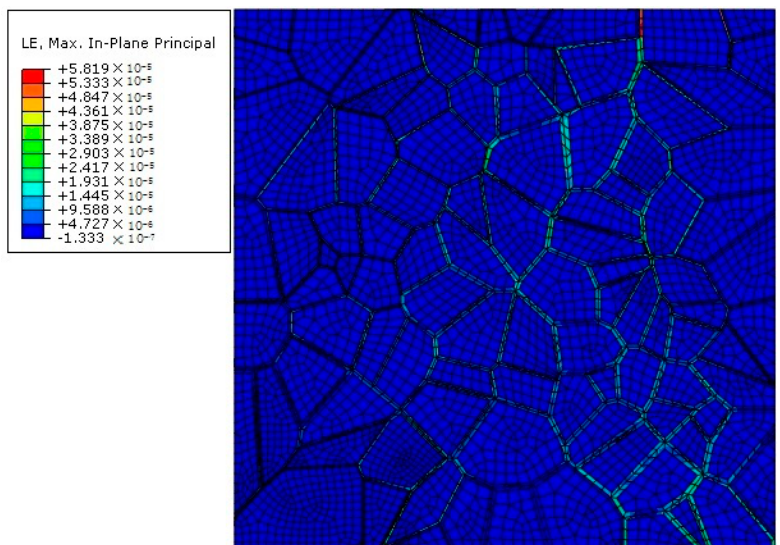
Figure 12. Strain diagram of the polycrystalline model without defects.